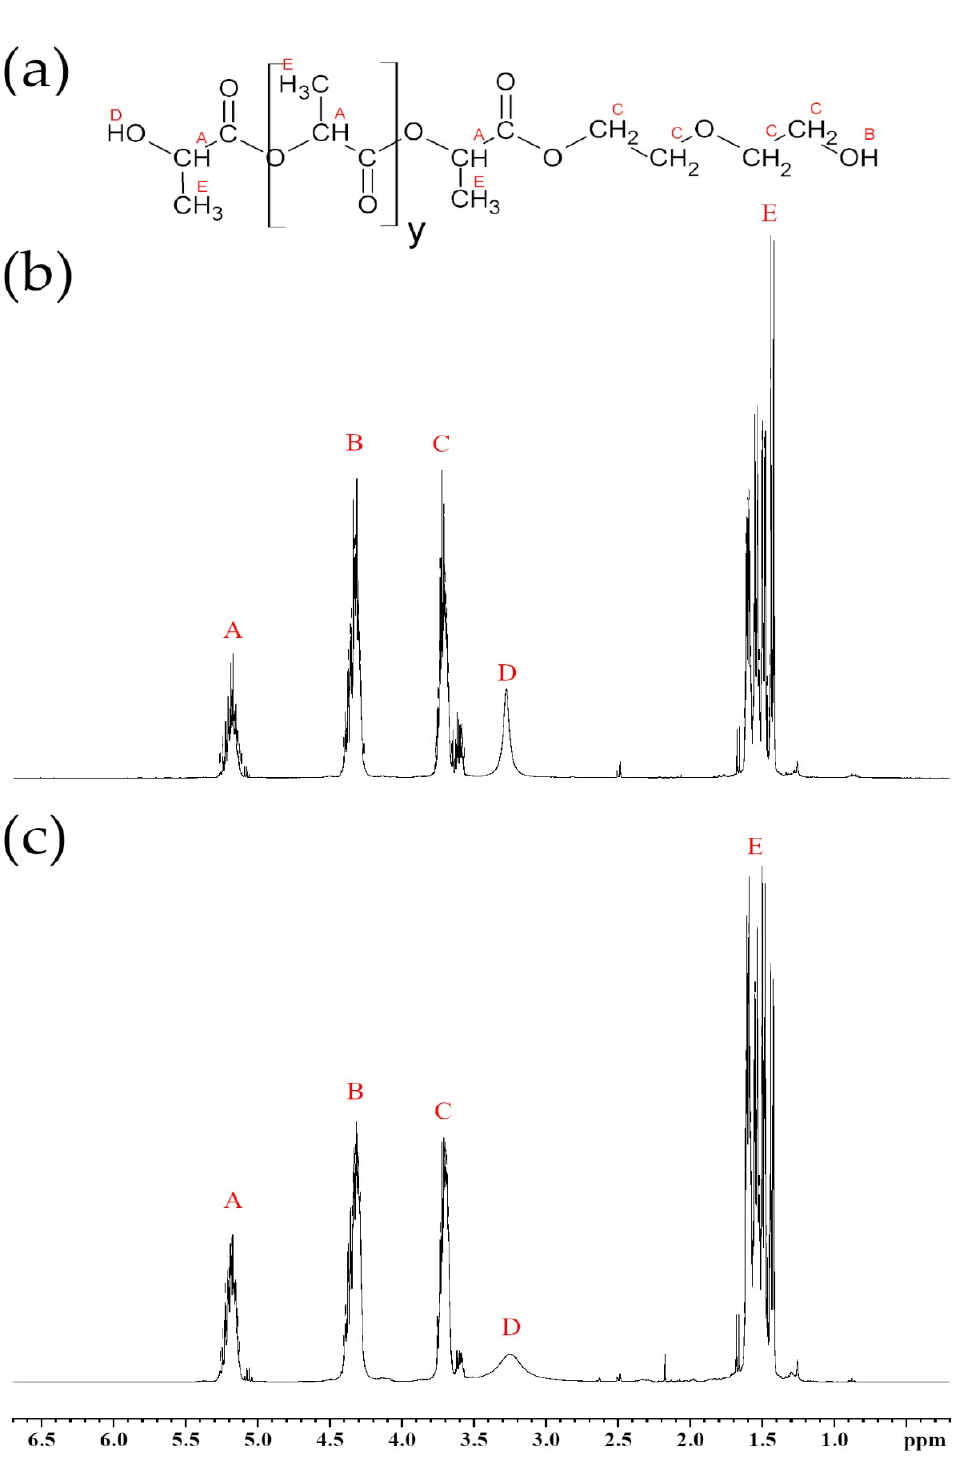
Figure 4. 1 H NMR spectra of new eco-polyols: ( a ) schematic structure of eco-polyols, ( b ) PLA0.4DEG spectrum, ( c ) PLA0.3DEG spectrum.